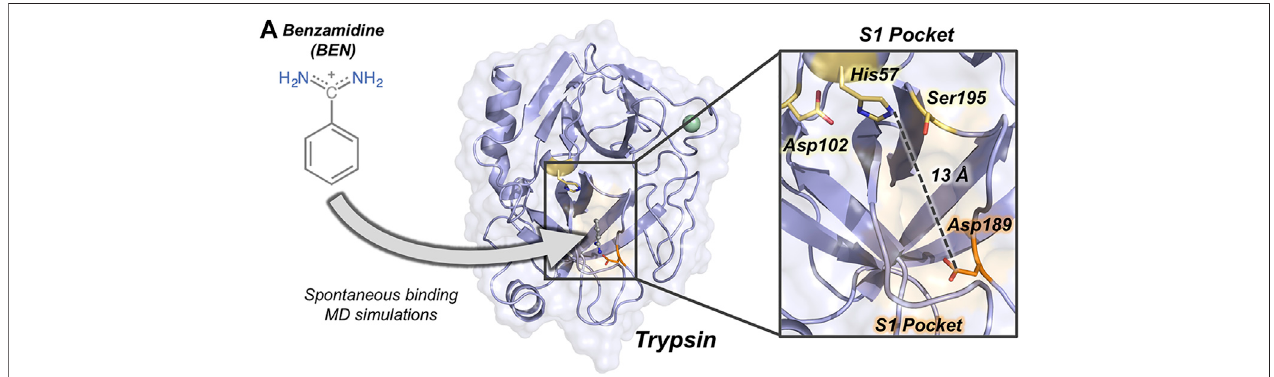
FIGURE1| Overviewoftrypsinstructure andS1pocket. (A) Trypsin(inpurple)structure corresponding toPDBID3PTBwithbenzamidineinhibitor(ingrey)bound to the S1 pocket (orange surface). His57 and Asp189 residues are highlighted in yellow and in orange sticks, respectively. Calcium ion is depicted as a green sphere. OverviewoftheS1pocketwithcatalyticresidues(Asp102,His57,andSer195)showninyellowsticks.Thedistancebetweenthecarbonoftheside-chainofAsp189and the side-chain of His57 is 13